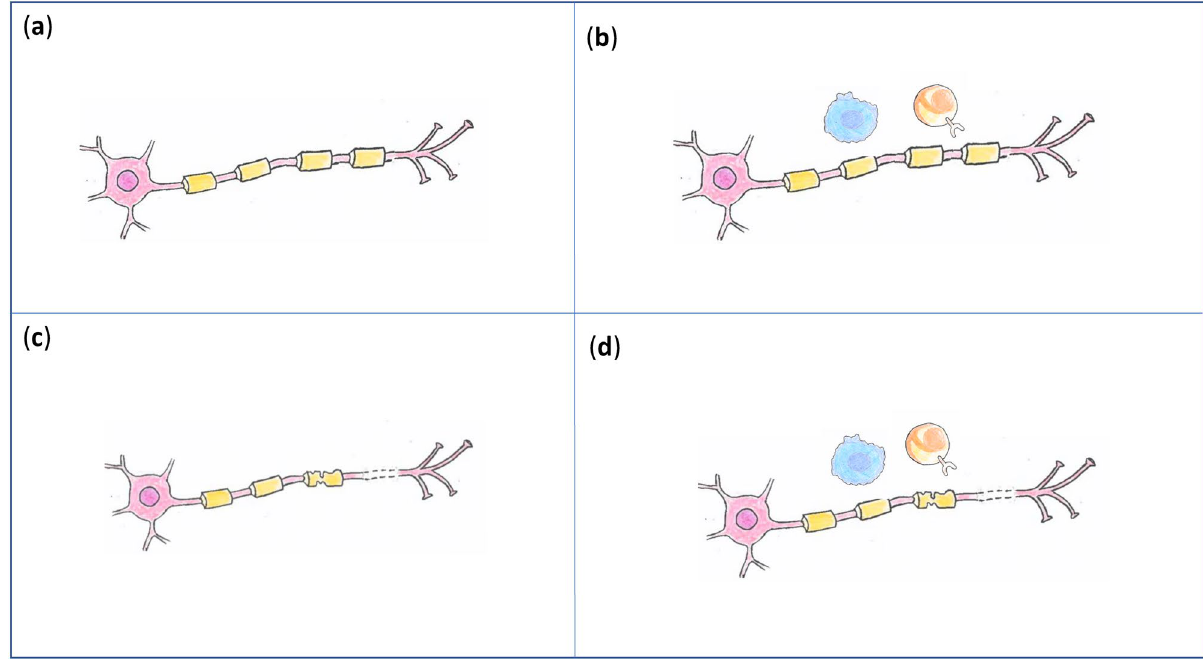
Figure 6. Four categories were considered based on disease status (MS versus controls) and group affiliation (group A and group B). The signature of intrathecal inflammation is simplified here by indicating only the immune cells. ( a ) Individuals without MS/CIS and without active intrathecal inflammation. ( b ) Individuals without MS/CIS with active elevated intrathecal inflammation. ( c ) MS/CIS patients without active intrathecal inflammation. ( d ) MS/CIS patients with active elevated intrathecal inflammation. Artwork performed by Kristiane